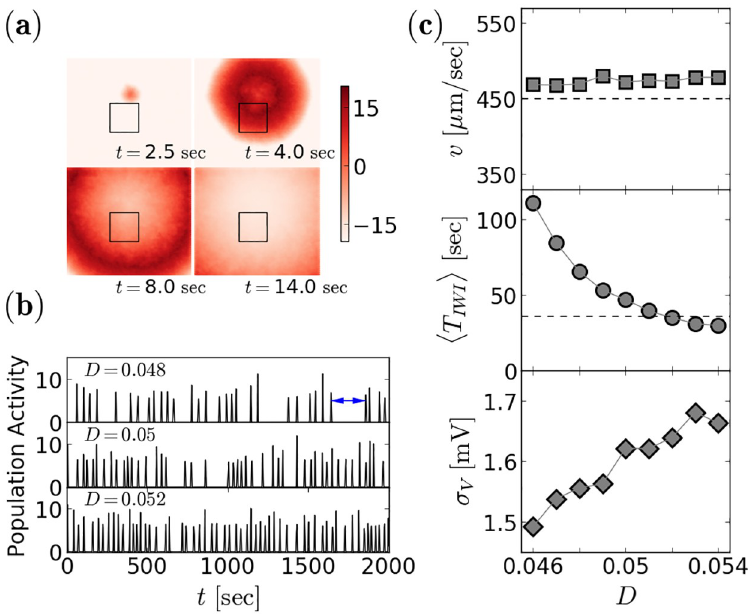
Fig 5. Large-scale simulations. A network of 12,100 GJ coupled and noisy Izhikevich neurons display spontaneously nucleated waves that propagate with velocities that are comparable to experimentally observed values. (a) Snapshots of the gating variable (associated to a proxy for the calcium concentration) at different time instances during one wave running through the system ( G = 0.4, D = 0.05). The small rectangle indicates the dimensions of the experimentally accessible observation area [11]. (b) Population activity A ( t ) (with Δ t A = 0.5 seconds, see Eq (6)) of the entire system over a larger time window for different noise levels. One wave, as shown in (a) collapses here into a single peak; time differences between adjacent peaks are the inter-wave intervals T IWI,i (one indicated by an arrow). (c) Mean velocity, mean inter-wave interval and standard deviation of the subthreshold membrane voltage as a function of the noise intensity for a small range around the estimated value D target = 0.05. Dashed lines indicate experimental mean values from Ref. [11], solid red line shows the wave speed for D = 0, extracted from the circle at G = 0.4 in Fig 3.